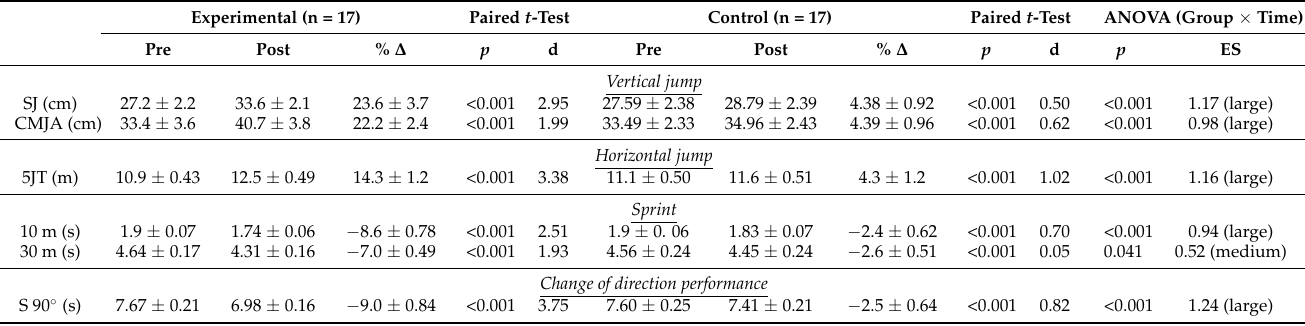
Table 4. Vertical and horizontal jump test, sprint times, and change of direction performance performances in experimental and control groups before and after 8-week intervention.